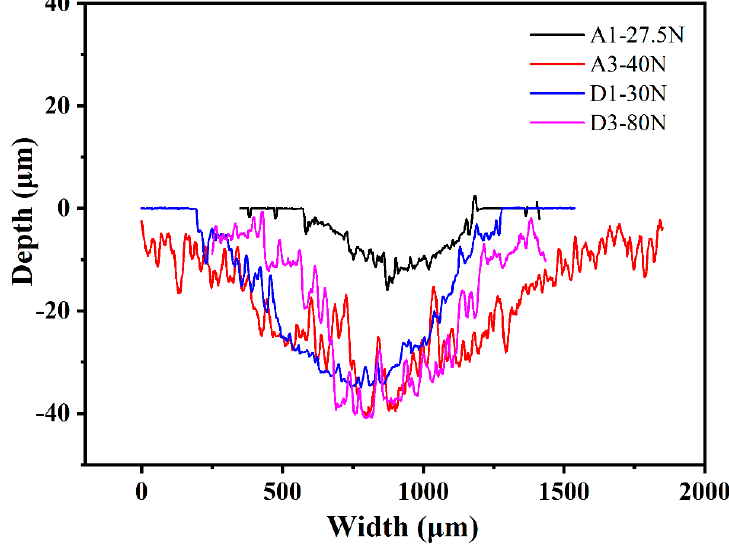
Figure 9. Cross-sectional profiles of the wear track of diamond films.